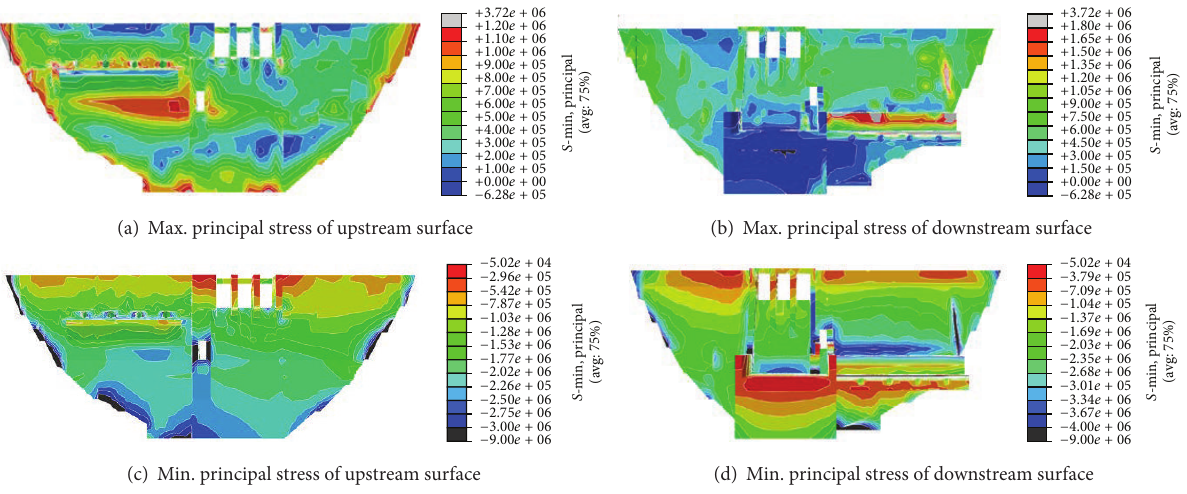
Figure 6: Principal stress contour of dam upstream/downstream under analysis Case 4 (unit: